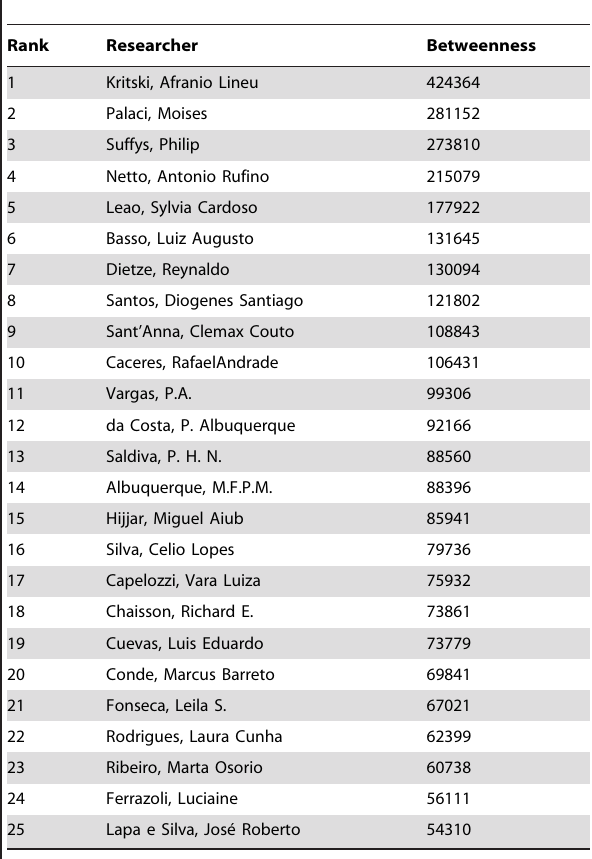
Table 5. Rank of institutions publishing articles on tuberculosis with Brazilian authors, 1995–2010, according to the ‘‘betweeness’’ centrality measure.